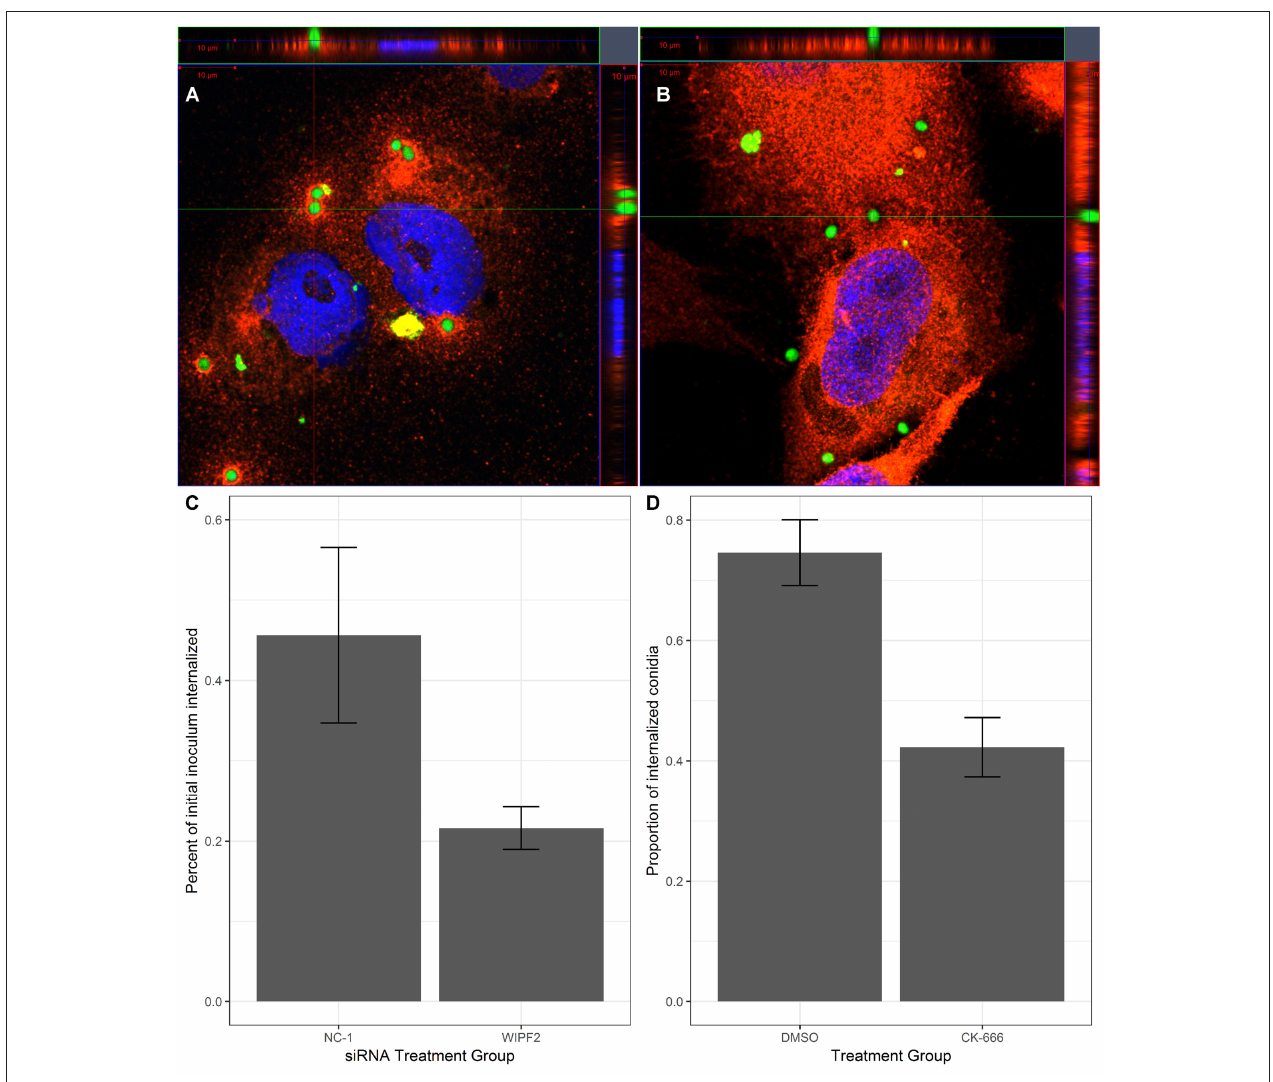
FIGURE 1 | WIPF2 and Arp2/3 mediate internalization of conidia into 1HAEo- cells. (A,B) 1HAEo- cells were infected with GFP-expressing A. fumigatus conidia for 15 min (A) or 1 h (B) . After infection, samples were immunolabeled using anti-WIPF2 antibody and DAPI and imaged using super-resolution confocal microscopy. (C) 1HAEo-cells were transfected with siRNA targeting no known gene in the genome (NC-1) or WIPF2. The nystatin protection assay was used to assess the extent of internalization. P < 0.05 (Student’s T -test). (D) 1HAEo-cells were treated with CK-666, an Arp2/3 inhibitor or DMSO vehicle before infection by GFP-expressing A. fumigatus conidia. Extracellular conidia were labeled by immunolabeling without permeabilization followed by manual counting. The proportion of observed conidia that were internalized is shown. P < 0.05 (Student’s T